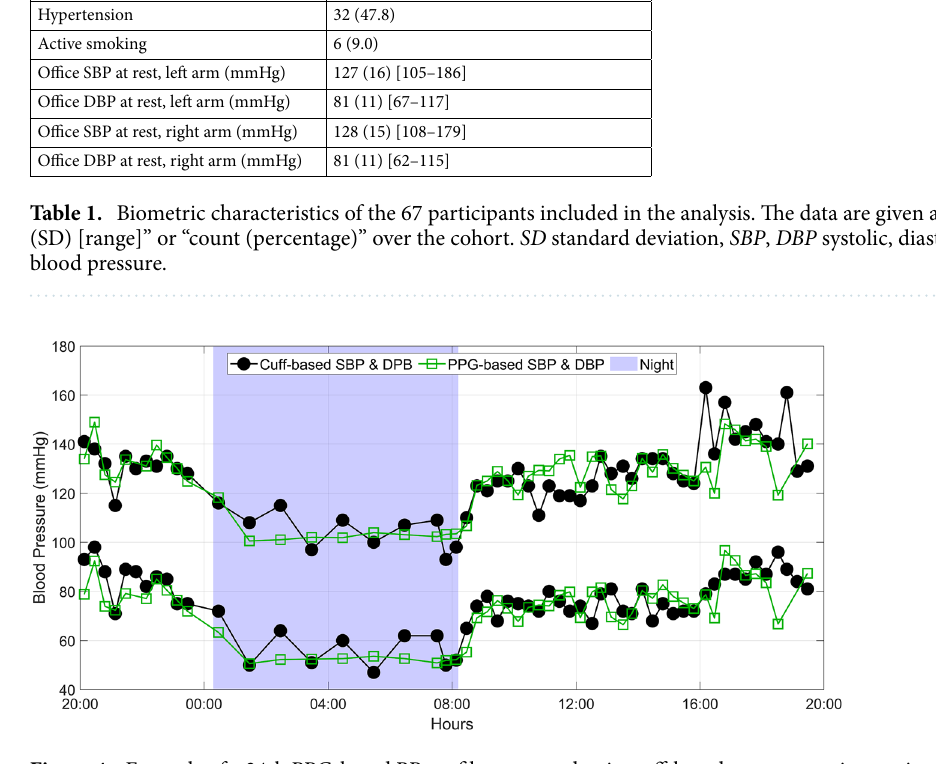
Figure 4. Example of a 24-h PPG-based BP profile compared to its cuff-based counterpart in a patient. PPG photoplethysmography, SBP systolic blood pressure, DBP diastolic blood